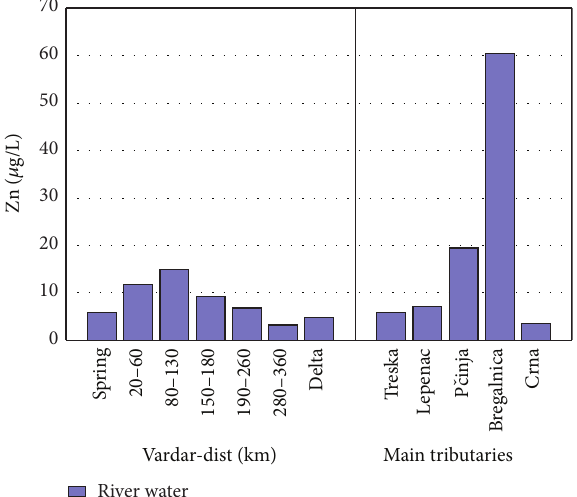
Figure 4: Factor 2 (factor scores) of river Vardar and main tributaries.